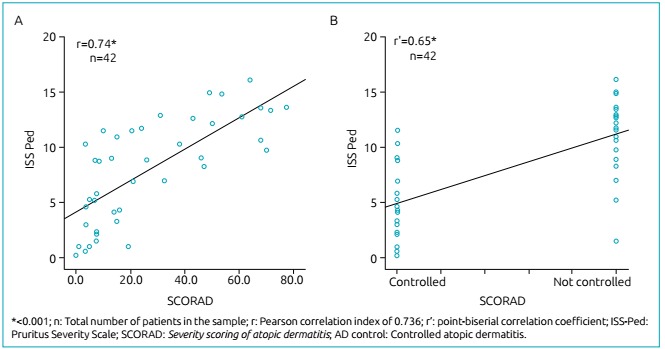
Correlation between the Pruritus Severity Scale and the Severity scoring of atopic dermatitis (A) and the atopic dermatitis control (B).